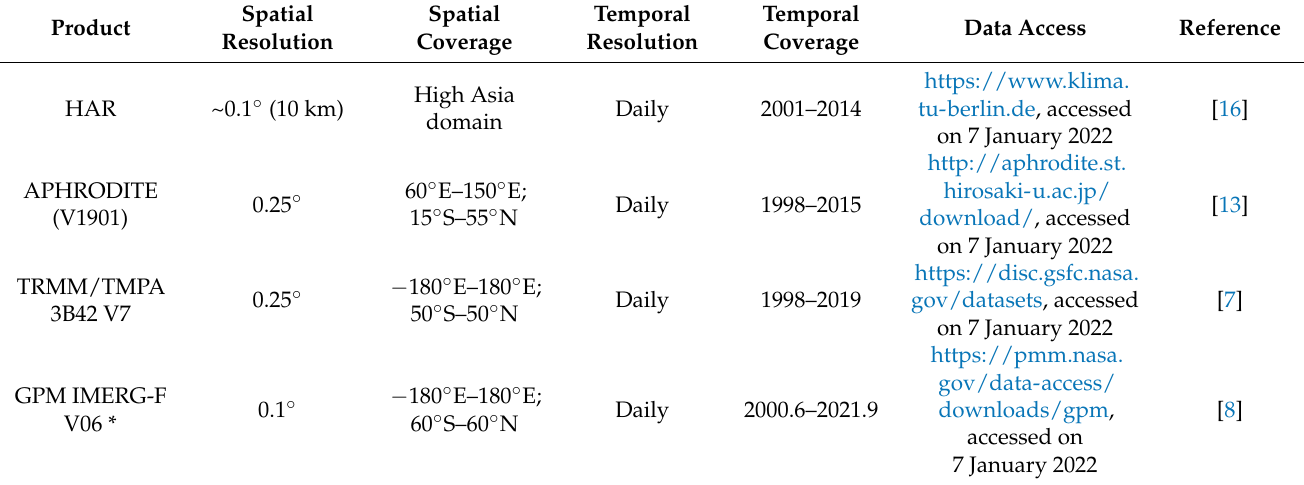
Table 2. Description of the four gridded precipitation